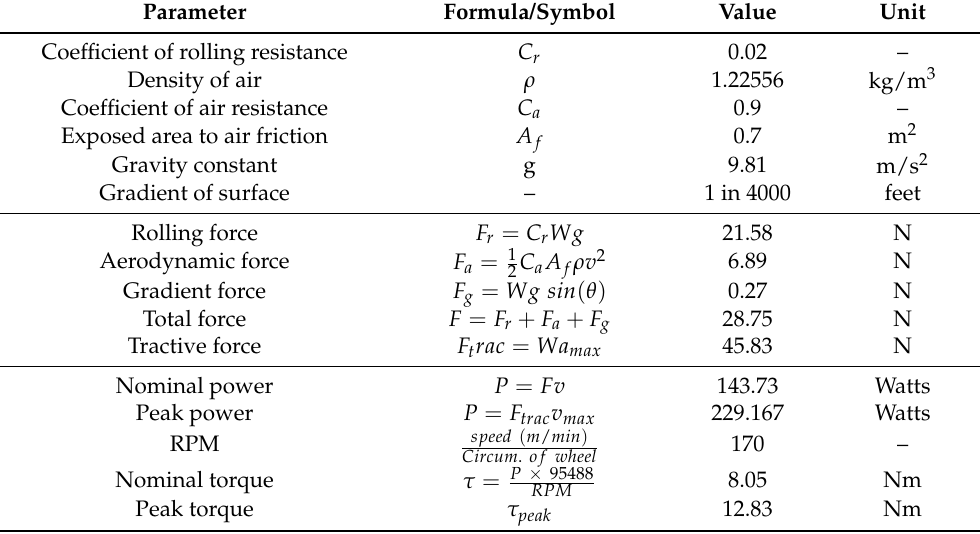
Table 2. Nominal values of physical